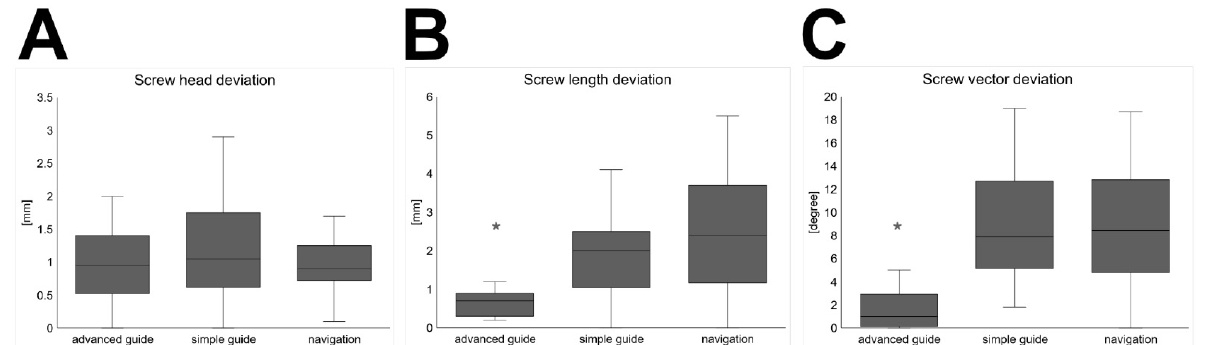
Figure 3. Boxplots of the measured deviation from virtual surgical planning (median, box height: interquartile range, whiskers: lowest and highest value). ( A ) Screw head deviation [mm]. ( B ) Screw length deviation [mm], significant difference of advanced guide to both other groups * = p < 0.003. ( C ) Screw vector deviation [degree], significant difference of advanced guide to both other groups * = p < 0.001.